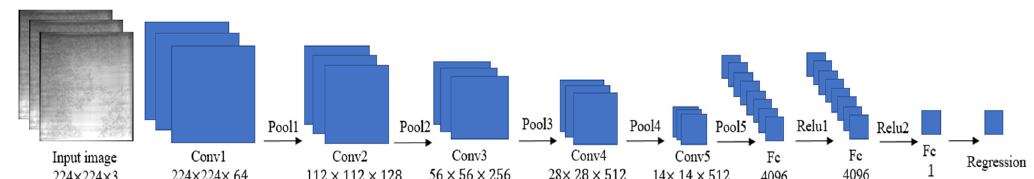
Figure 3. The VGG-16 network structure after adjustment.